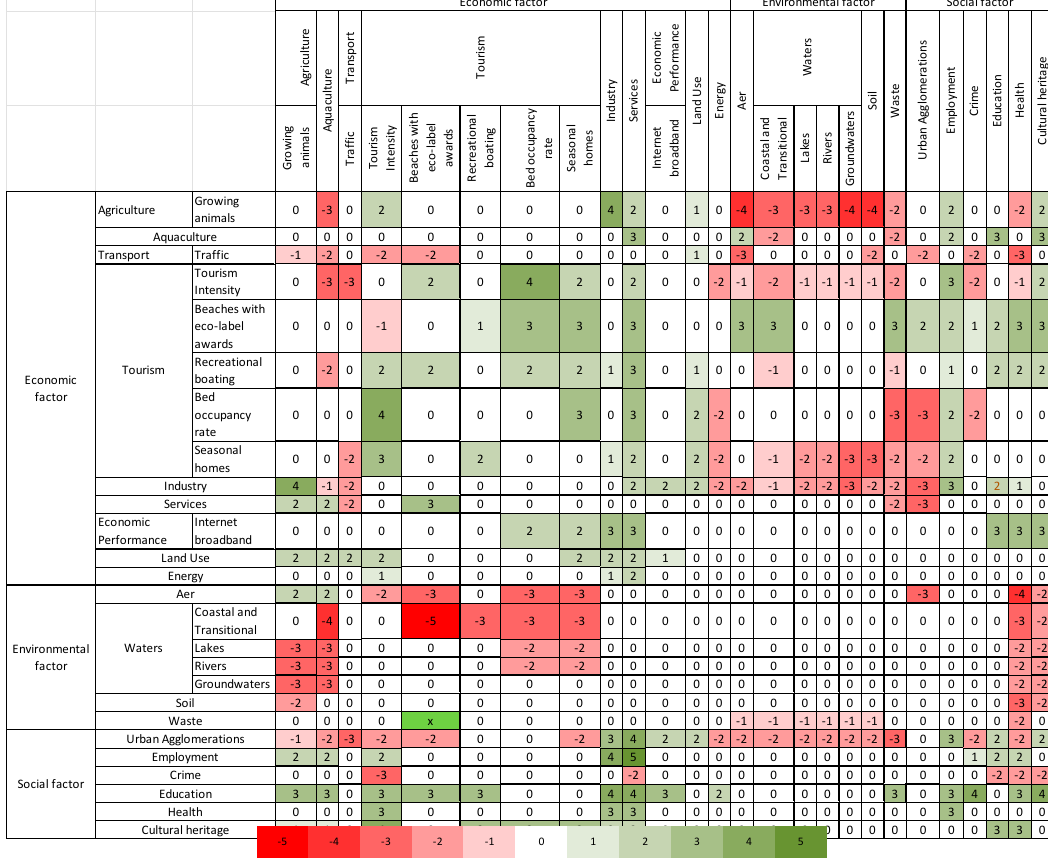
Table 2. Valuation impact of activities (authors).